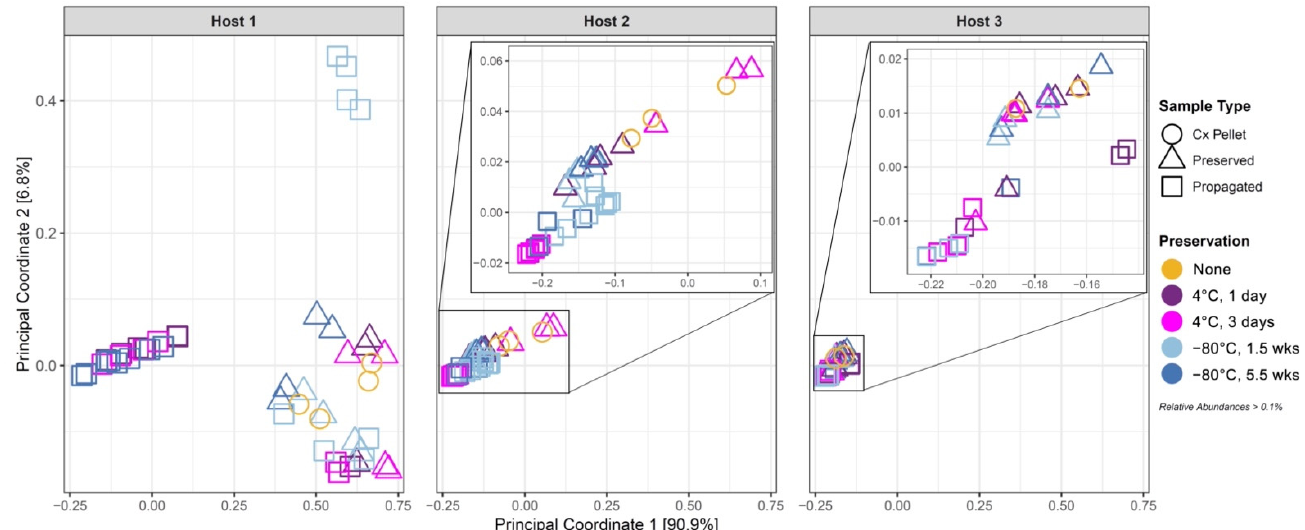
Figure 3. Principal coordinate analysis (PCoA) using Bray–Curtis distance measurement, performed on all samples as a single dataset.